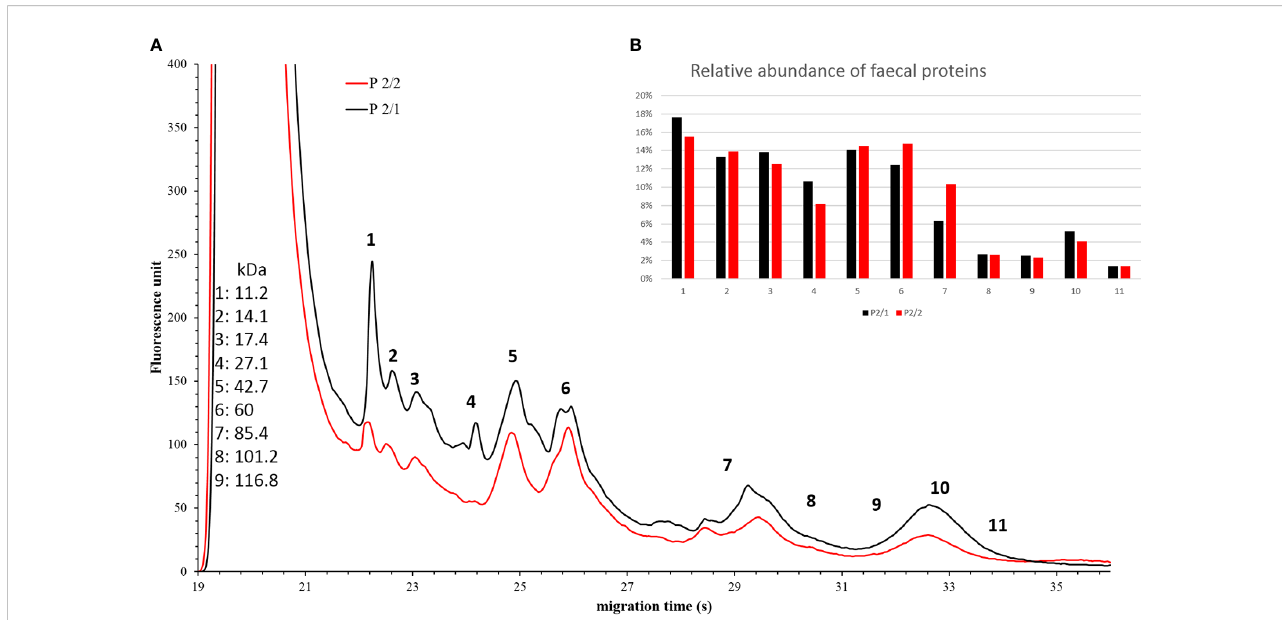
FIGURE 7 Faecal protein analysis (A) and relative abundance of faecal proteins (B) of Patient #2 before (black) and after (red) FMT. The numbered data points refer to different components. The molecular weights of the components can be seen on the left side in kilodaltons. Panel b shows the relative abundance of these components. In the post-FMT samples from Patients #6 , we observed an increase in the relative abundance of component 4, 5, 6 and 7 (Figure